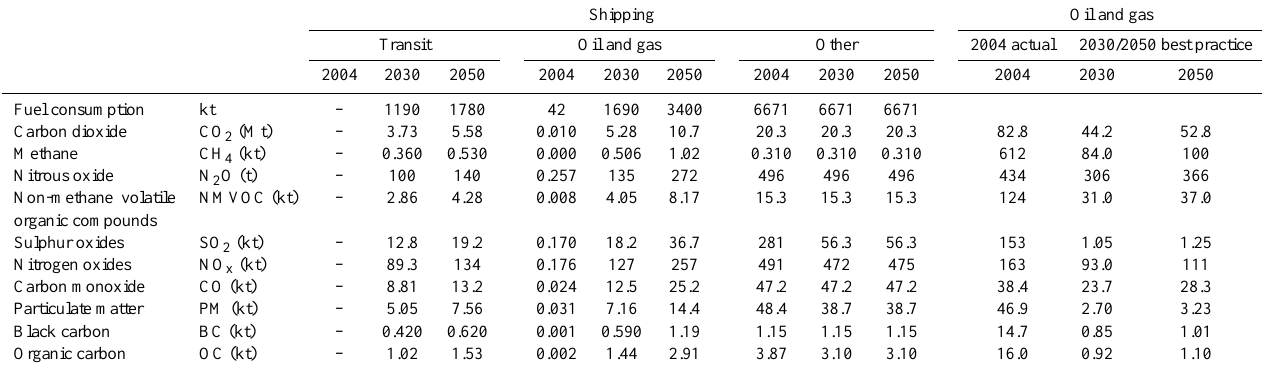
Table 6. A comparison of the emissions from shipping and extraction of oil and gas. The shipping is split between transit, oil and gas, and other activities. The oil and gas covers actual emissions in 2004 and emission based on best practice in 2030 and